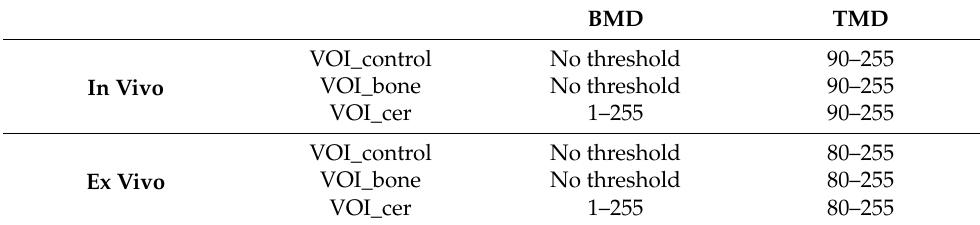
Table 2. Thresholds for density